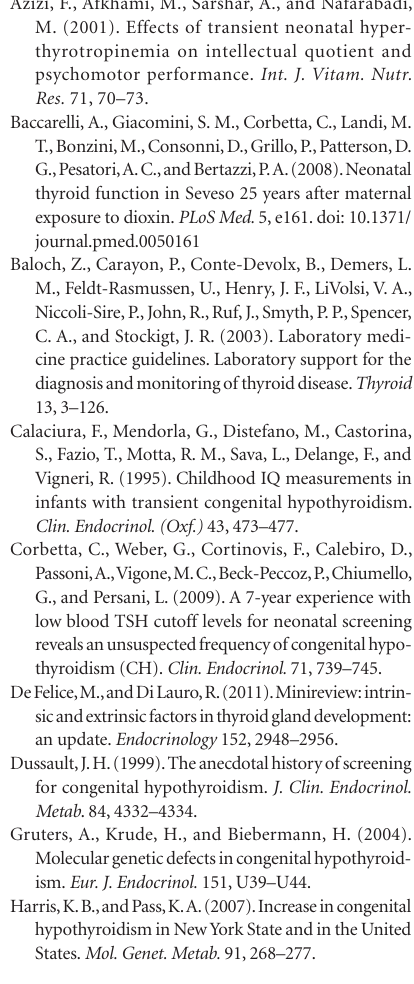
Table 1 | Possible explanations for the increased incidence of CH newborns. Low TSH screening cutoffs Ethnic susceptibility (Asian and Black with highest and lowest risk, respectively) Low/high iodine